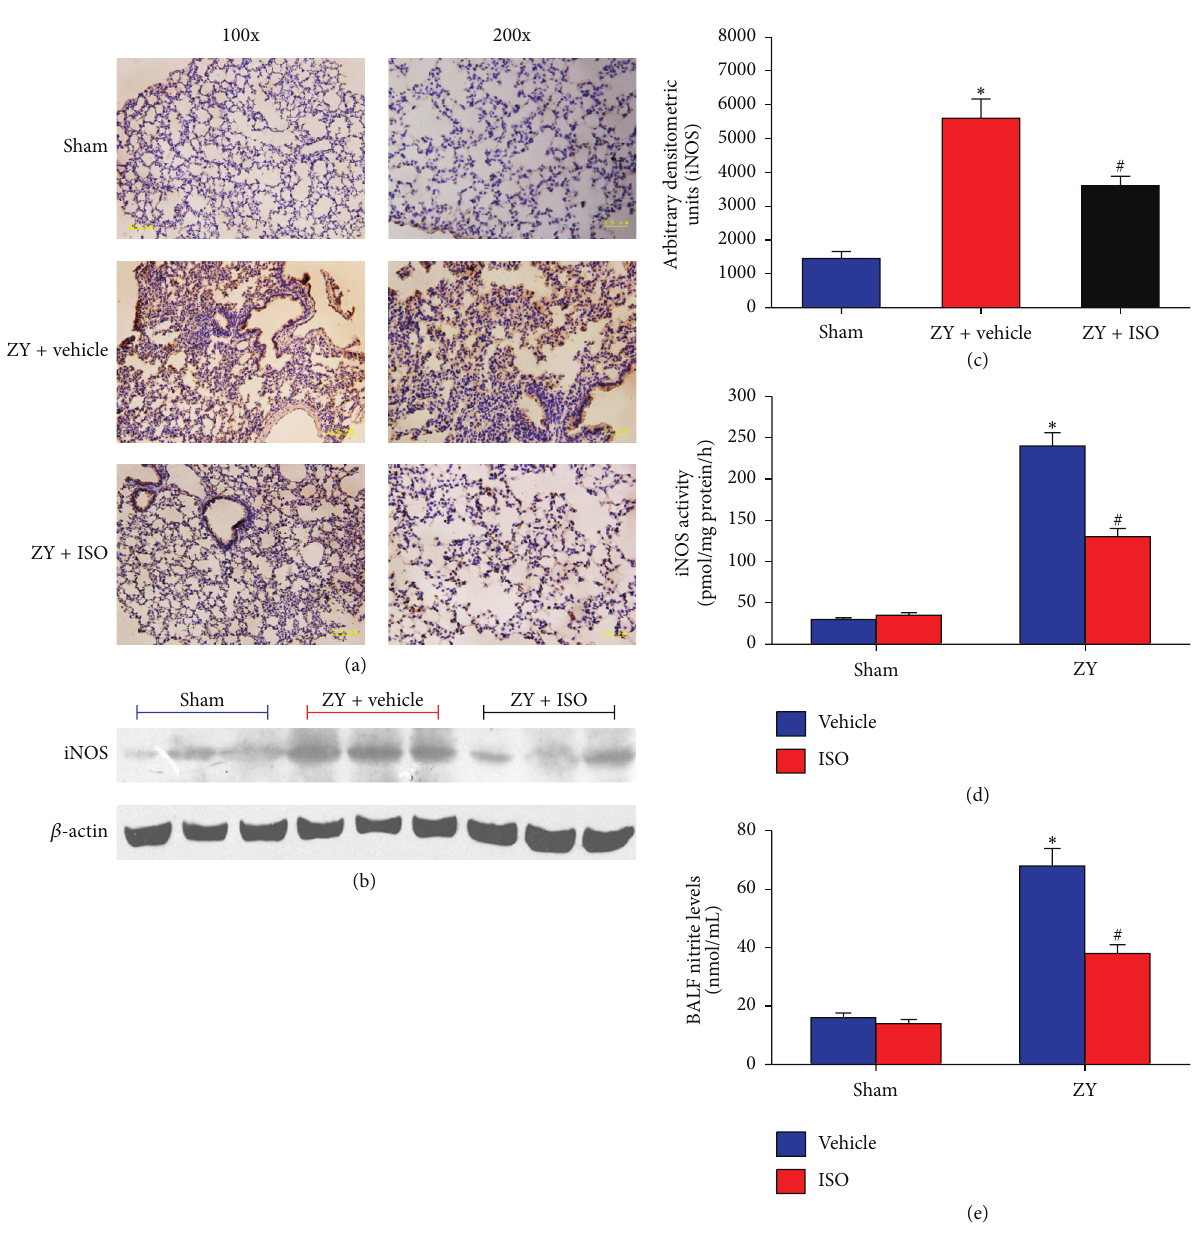
Figure 6: Effects of 0.7% ISO treatment on iNOS/NO production in ZY-treated lung at 24hrs. iNOS protein expression was assayed by immunohistochemistry (a) and western blot (b). (c) The average iNOS staining from western blots was quantified by arbitrary densitometry units. (d) iNOS enzyme activity in the four treatment groups. (e) Nitrite levels in the four treatment groups as an indicator of NO formation. TheanimalsweretreatedasshowninFigure 1(a).Datarepresentmeans ± SD( 𝑛 = 10 micepergroup). ∗ 𝑃 < 0.05 versussham+vehicle; # 𝑃 < 0.05 versus ZY + vehicle. Table 1: Total and differential cell counts in bronchoalveolar lavage fluid ( × 10 5 cells/mL). Sham + vehicle Sham + ISO ZY + vehicle ZY + ISO 𝑃 Total cells 1.35 ± 1.00 1.30 ± 1.01 2.10 ± 0.68